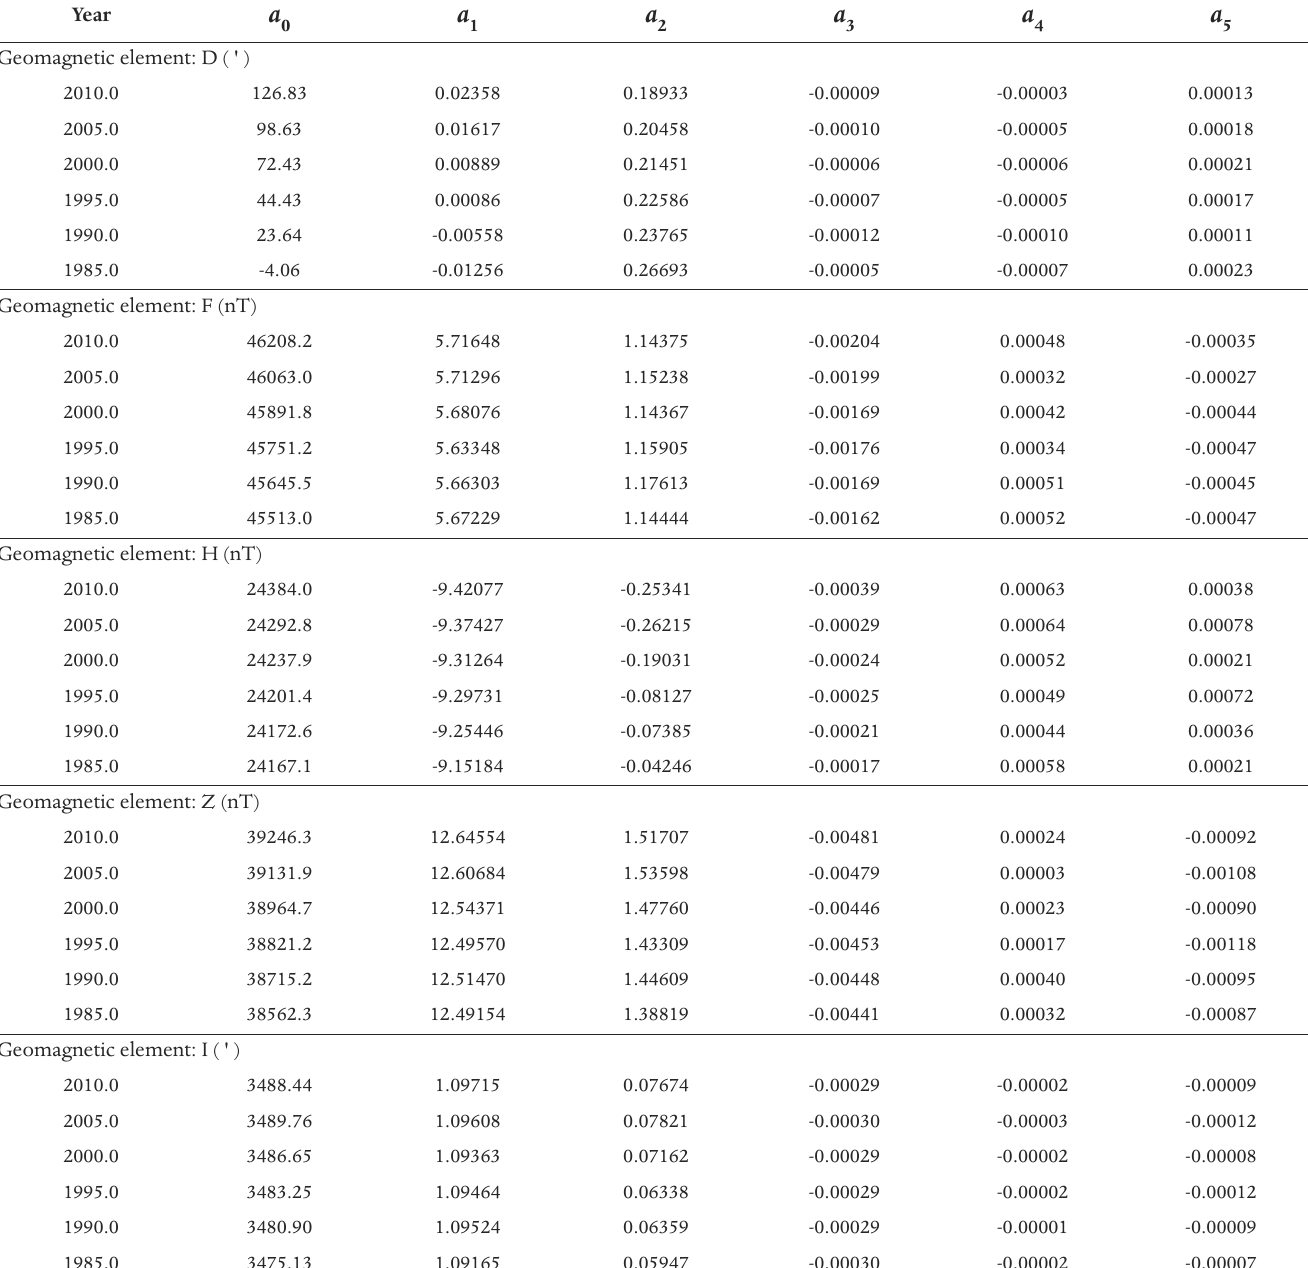
Table 4. Coefficients of reduced normal field for epochs 1985 to 2010 for all magnetic elements. Latitude z and longitude m are referred to 42˚ N and 12˚ E respectively, with values expressed in minutes of arc. z = (Lat. − 42˚) in minutes, m = (Long. − 12˚) in